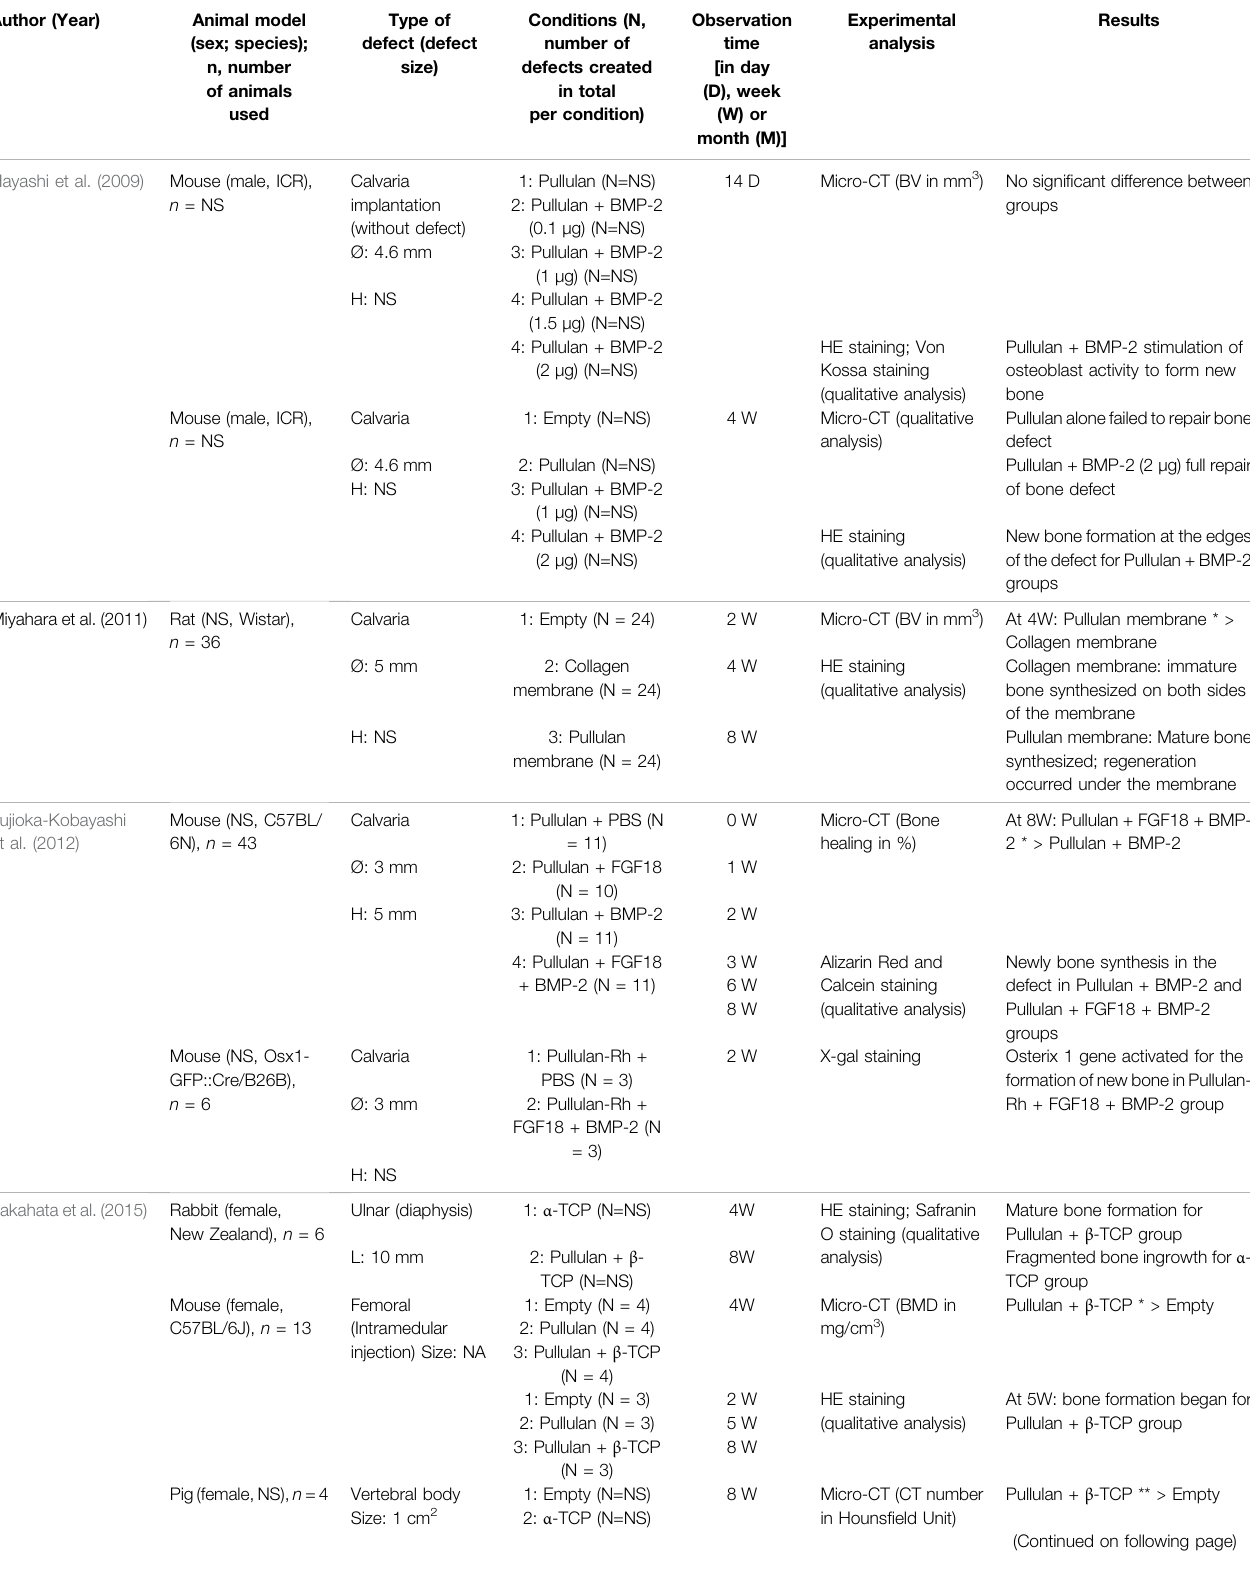
TABLE 4 | Preclinical studies using Pullulan scaffolds for bone regeneration in orthotopic sites. Author (Year) Experimental